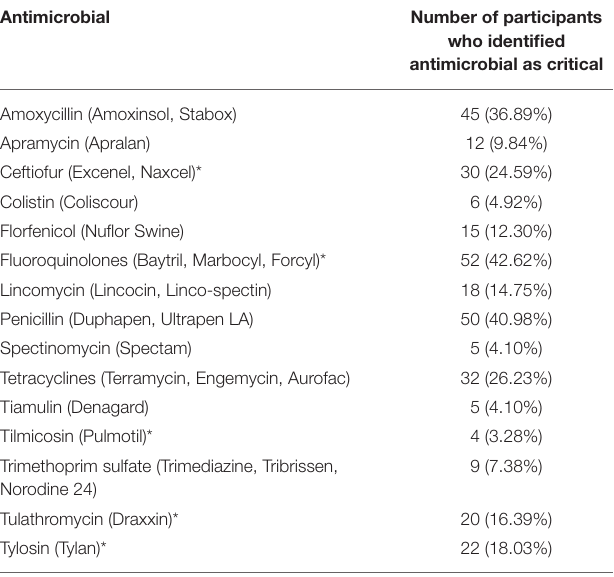
TABLE 4 | Antimicrobials identified as HP-CIAs by UK pig farmers ( n = 122) from a provided list of drugs including both generic and trade names. Antimicrobial Number of participants